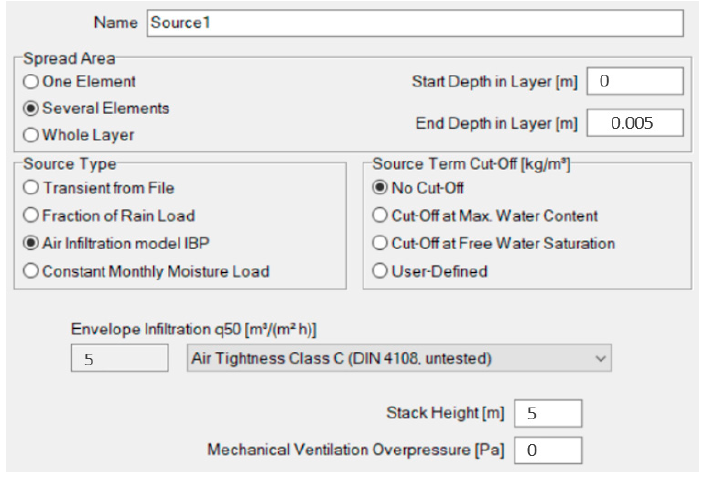
Figure 9. WUFI ® Pro settings for moisture ingress through the pliable membrane.